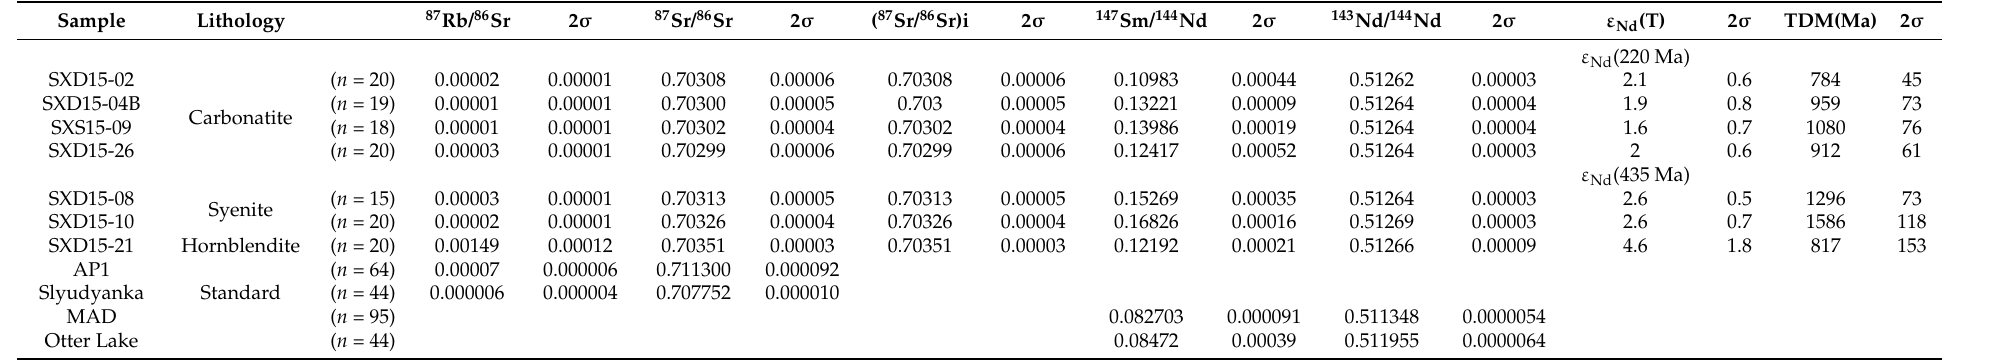
Table 3. Average apatite Sr–Nd isotope data obtained by